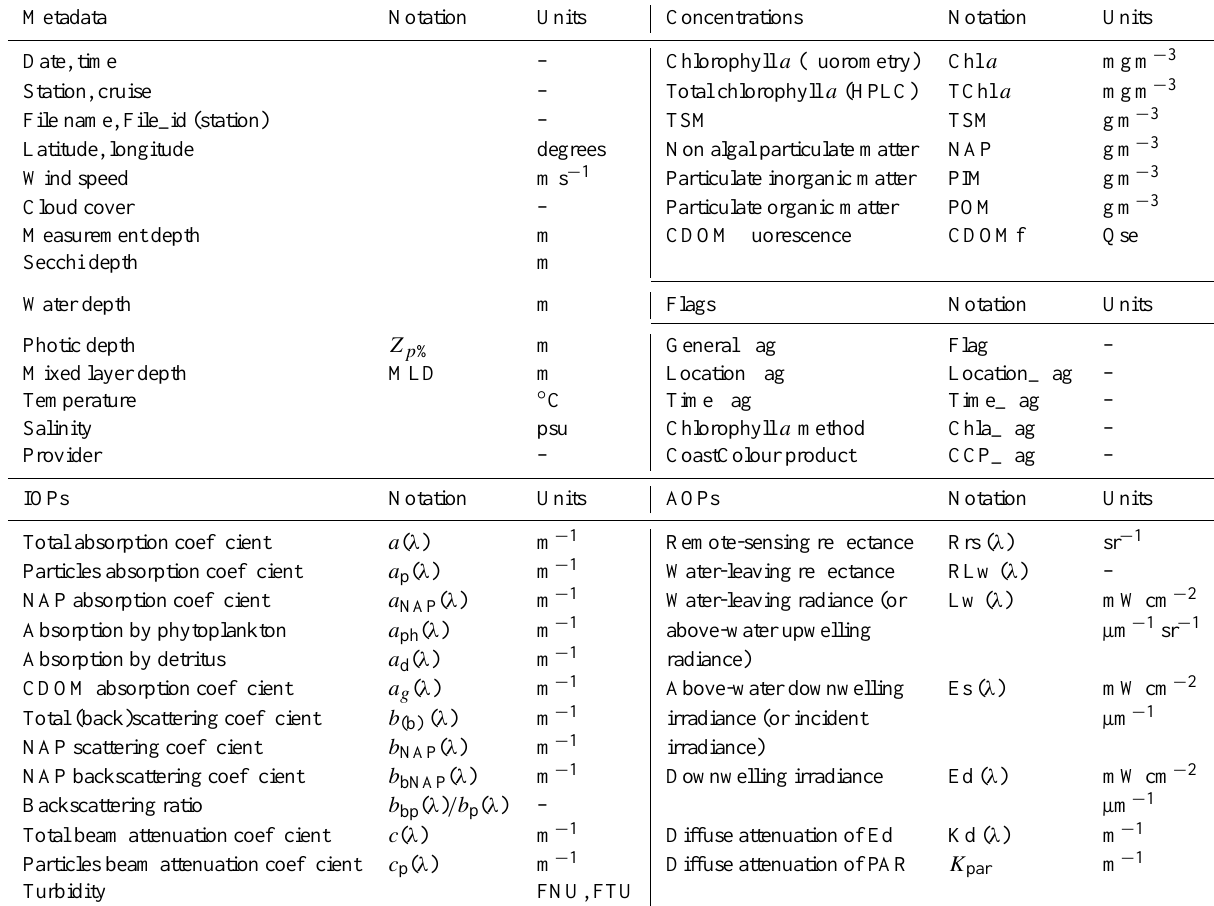
Table 2. Metadata, IOPs, and AOPs given at wavelength λ , and biogeochemical in situ measurements available for the CoastColour sites. The two notations Chl a and TChl a refer to chlorophyll a concentration measured by high-performance liquid chromatography (HPLC) and by fluorometry